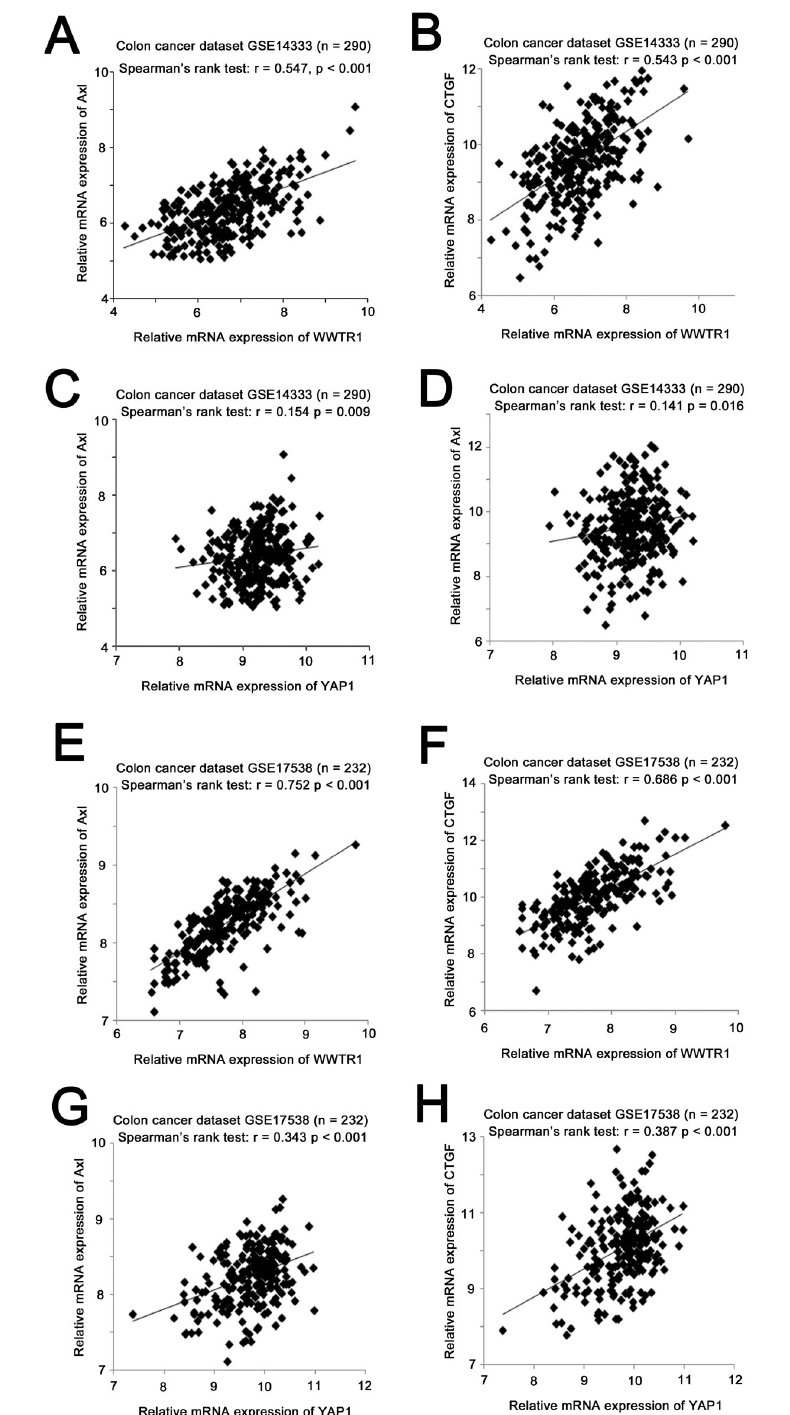
Fig 1. The correlations among mRNA expression of TAZ (WWTR1), YAP (YAP1), AXL and CTGF in colon cancer specimens. Scatter plots for (A) TAZ mRNA expression versus AXL mRNA expression, (B) TAZ mRNA expression versus CTGF mRNA expression, (C) YAP mRNA expression versus AXL mRNA expression, and (D) YAP mRNA expression versus CTGF mRNA expression in the GSE14333 colon cancer datasets, and (E) TAZ mRNA expression versus AXL mRNA expression, (F) TAZ mRNA expression versus CTGF mRNA expression, (G) YAP mRNA expression versus AXL mRNA expression, and (H) YAP mRNA expression versus CTGF mRNA expression in the GSE17538 colon cancer